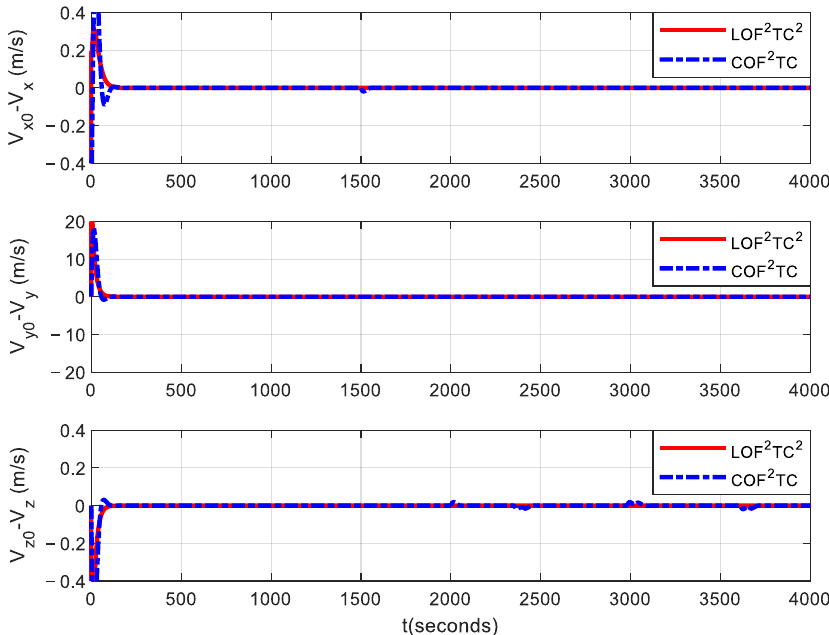
Figure 8. Relative velocity tracking error for formation maintenance.